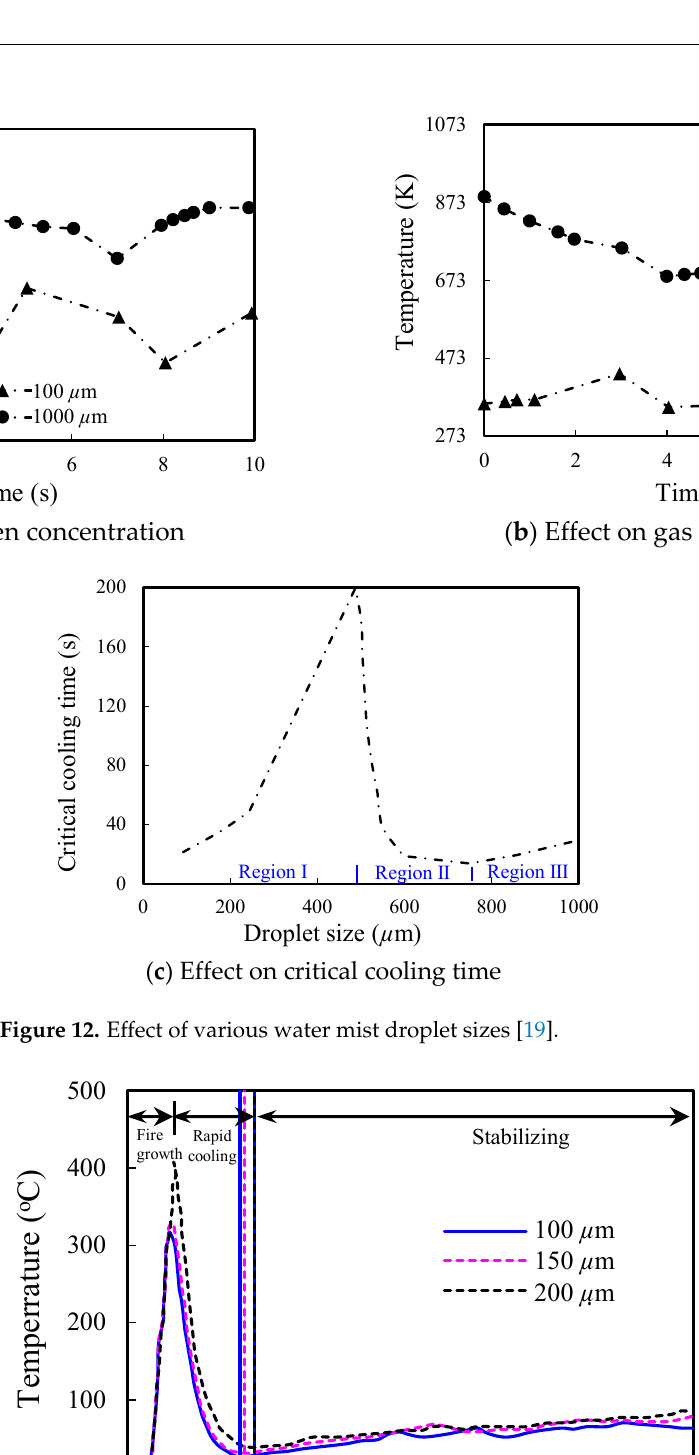
Figure 13. Time histories of temperatures for various water mist droplet sizes [29].